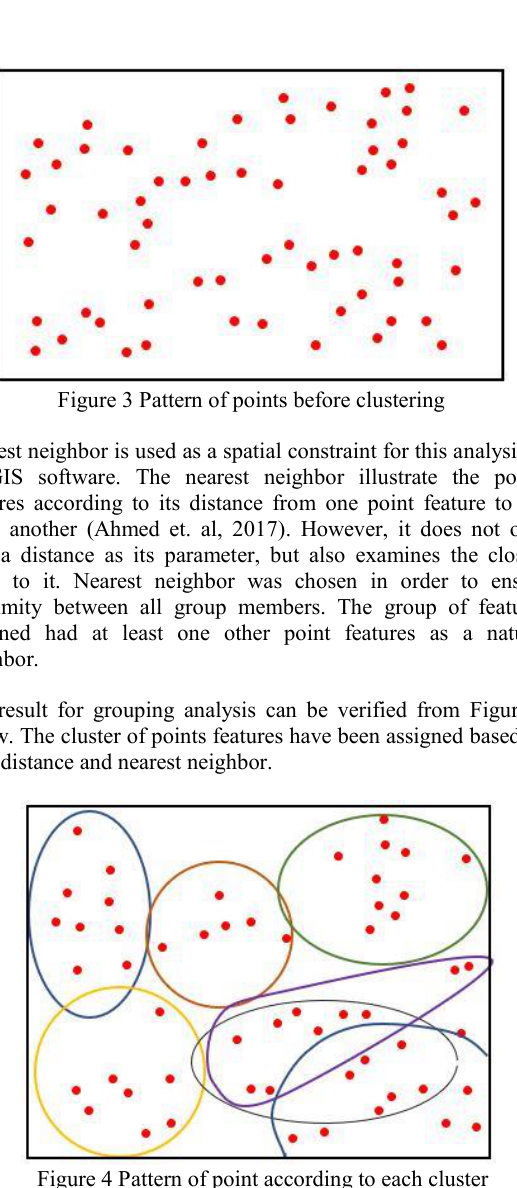
Figure 2 Flow of generate cluster in ArcGIS software